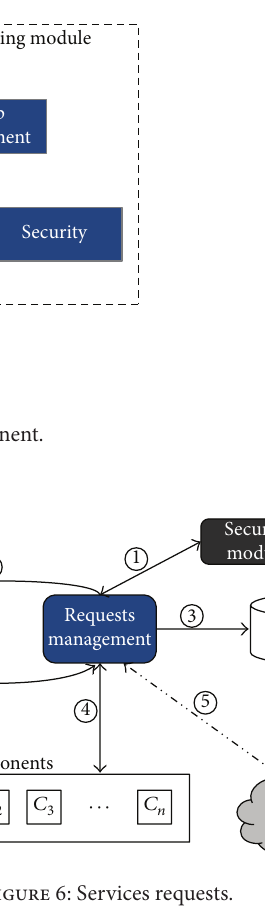
Figure 5: data distribution, data retrieve, replica management,